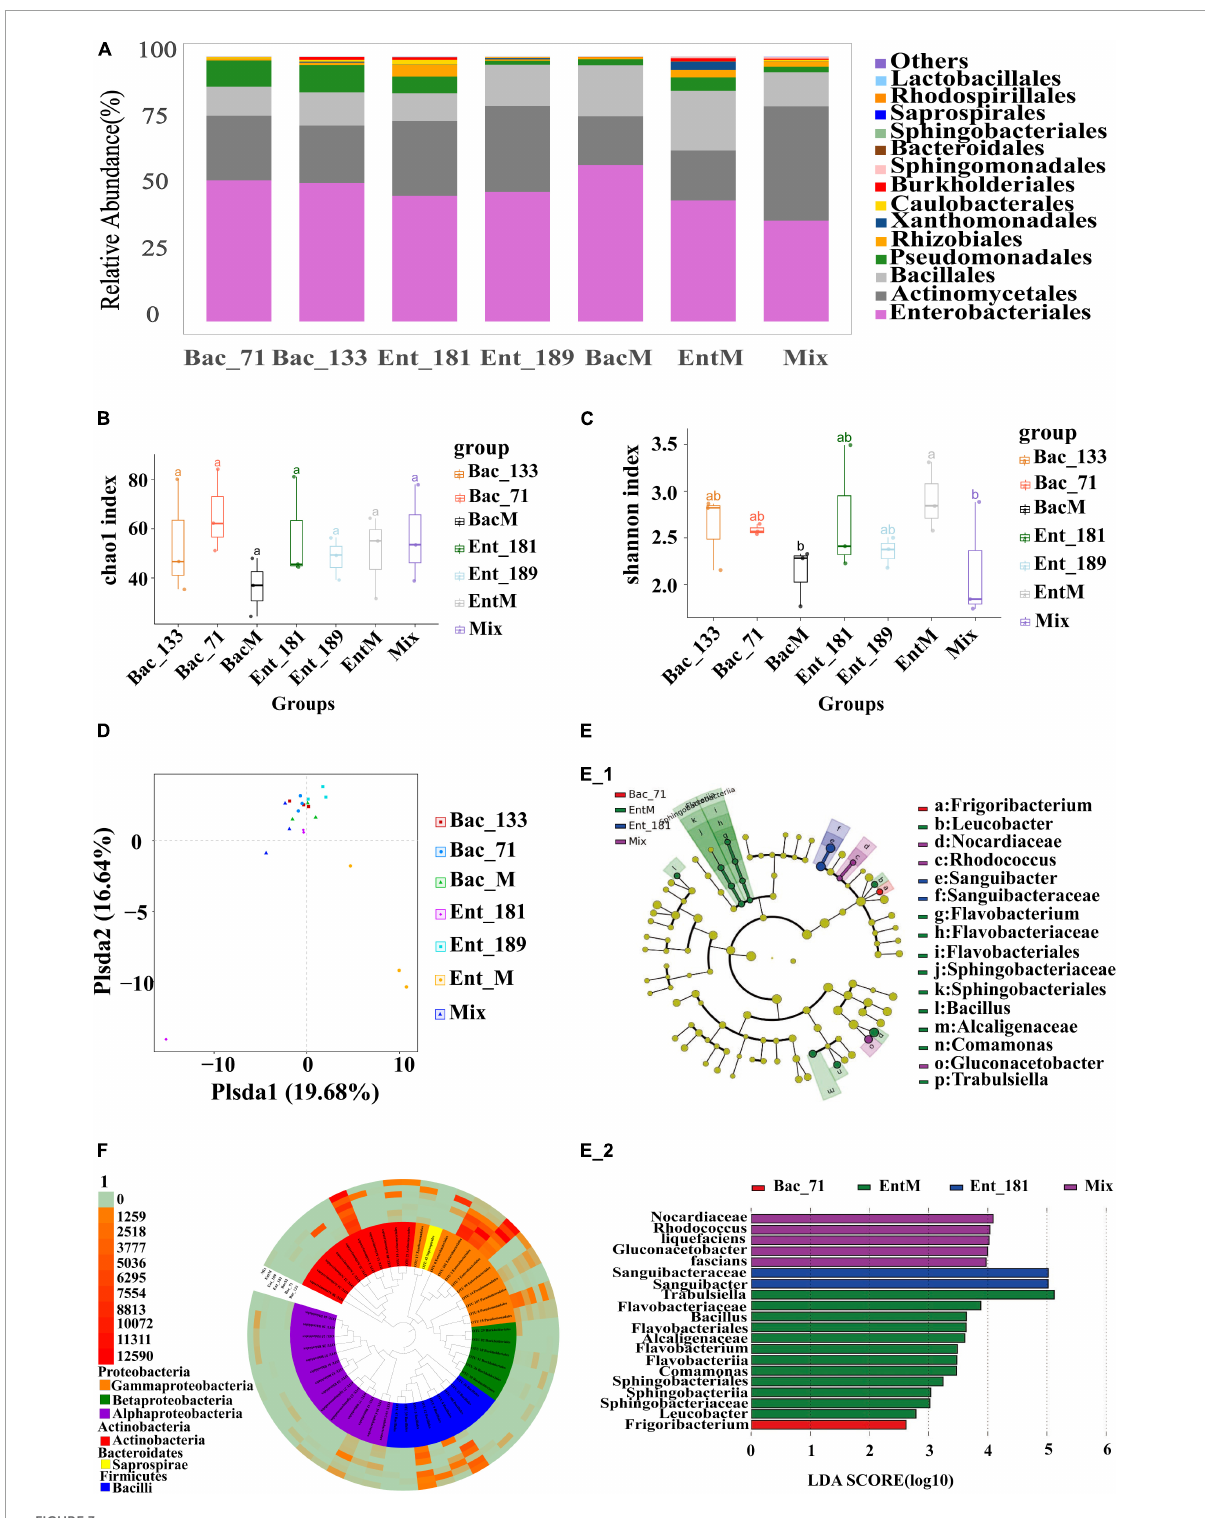
FIGURE3 Secondary analysis of the composition and diversity of the flora of the roots of tomato after the infestation of four single and mixed bacteria. (A) Diagram of the species structure of 4 single bacteria and the mixed bacteria (at the order level, selecting the top 15 flora in terms of abundance). (B,C) The Chao1 boxplot and Shannon boxplot of 4 single bacteria and the mixed bacteria (the letters above represent the differences between groups). (D) PCoA analysis of single bacteria and the mixed bacteria, principal coordinated analysis (PCoA) derived